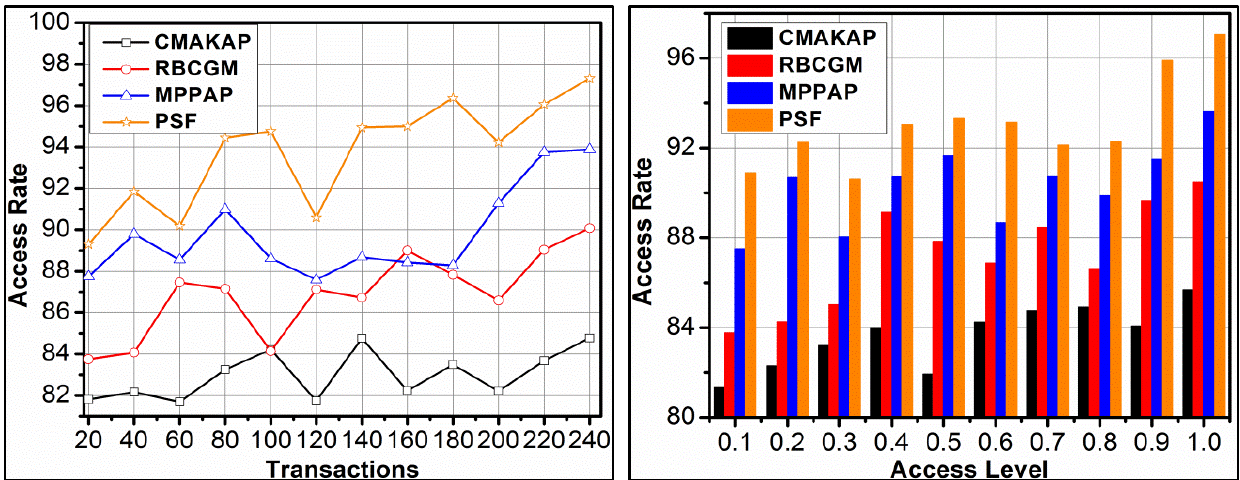
Figure 10. Access Rate Analysis.